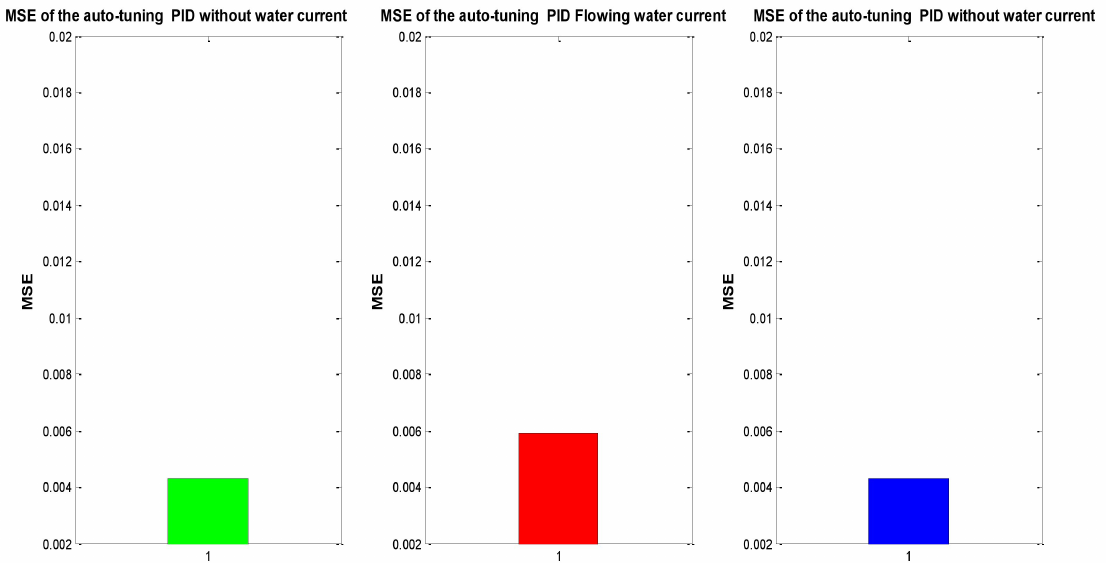
Figure 14. MSE of the auto-tuned PID position tracking.